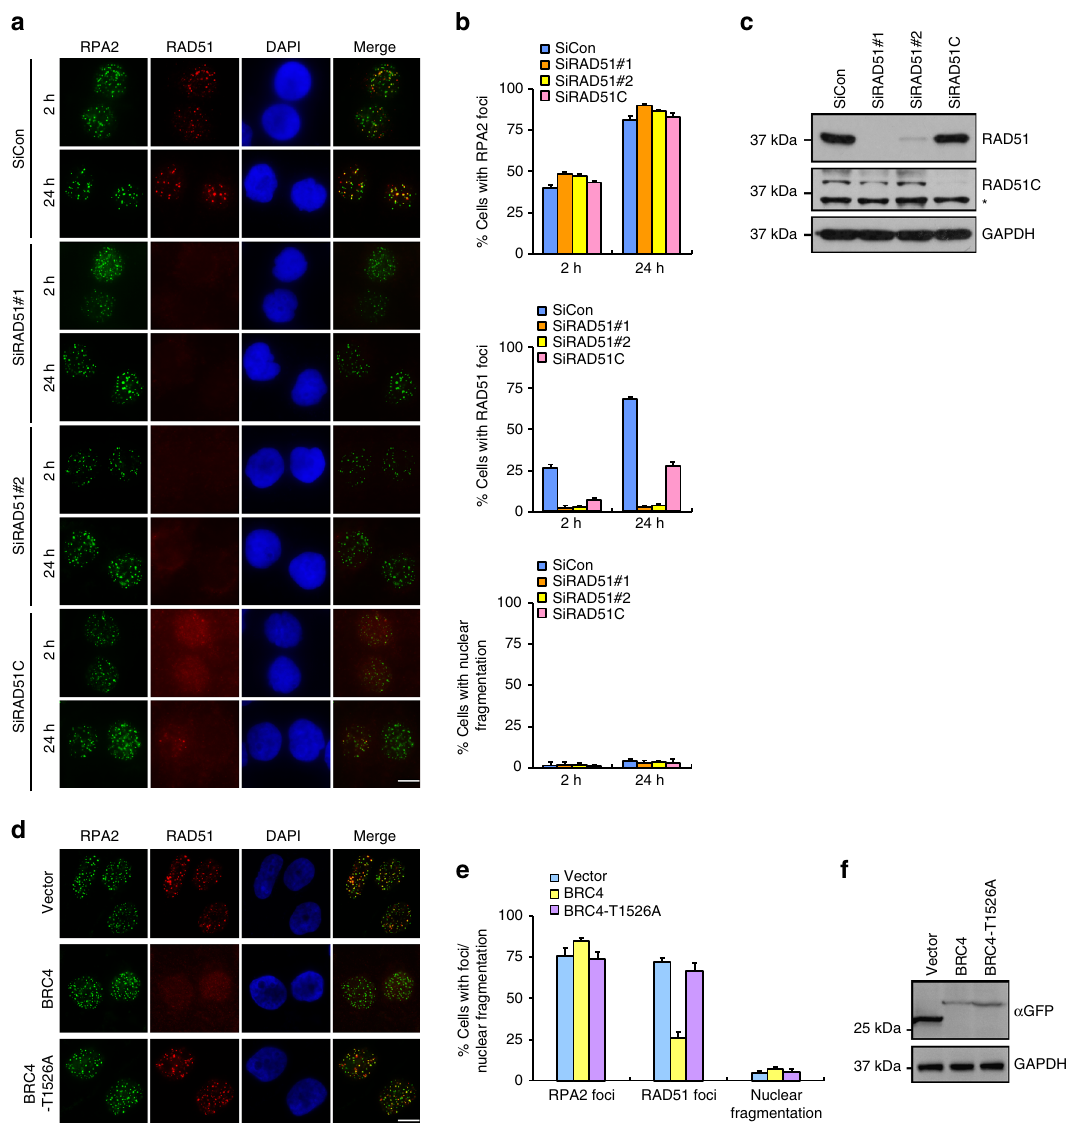
Fig. 2 BRCA2 suppresses gross genomic instability independently of RAD51. a HeLa cells were transfected with control siRNA or siRNAs against RAD51 or RAD51C. Forty-eight hours post transfection, cells were exposed to 10 Gy IR and then allowed to recover for 2 or 24 h before being processed for immuno fl uorescence using antibodies against RPA2 and RAD51. Representative RPA2/RAD51 foci and DAPI-stained nuclei are shown. b Quanti fi cation of RPA2/RAD51 foci and nuclear fragmentation. Data represent mean ± SEM of three independent experiments. Over 100 cells were counted in each experiment. c Knockdown ef fi ciency of RAD51/RAD51C was con fi rmed by western blotting. The asterisk indicates a nonspeci fi c band. d HeLa cells were electroporated with GFP-tagged wild-type BRC4 or the T1526A mutant. Twenty-four hours later, cells were exposed to 10 Gy IR and then allowed to recover for 24 h before being processed for immuno fl uorescence using antibodies against RPA2 and RAD51. Representative RPA2/RAD51 foci and DAPI- stained nuclei are shown. e Quanti fi cation of RPA2/RAD51 foci and nuclear fragmentation. Data represent mean ± SEM of three independent experiments. Over 100 cells were counted in each experiment. f BRC4 expression was con fi rmed by western blotting. Scale bars, 10 μ